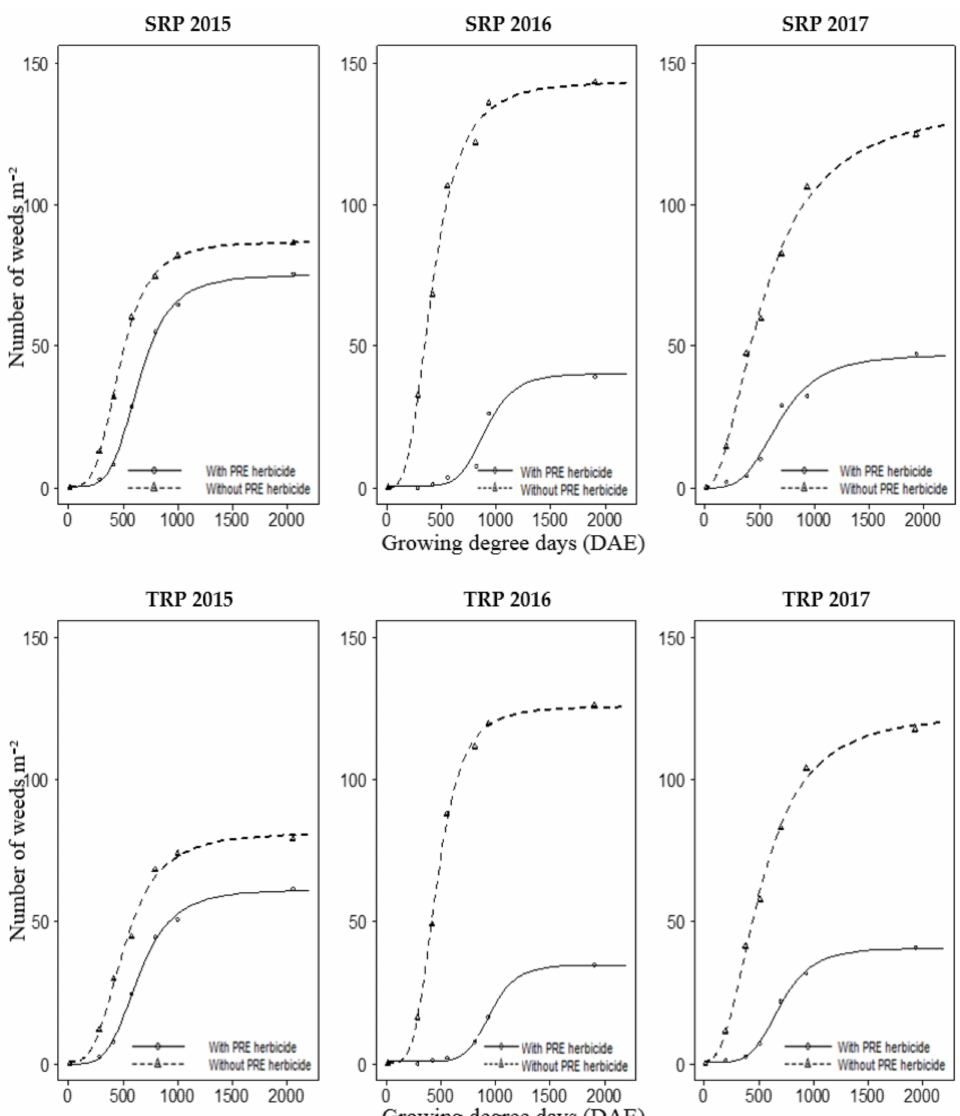
Figure 1. Total weed density response to increasing duration of weed interference as represented by growing degree days (d after emergence, DAE) grown without and with PRE herbicides in standard (SRP) and twin-row (TRP) planting patterns, at Padina, Serbia, 2015–2017. Generally, the highest weed density (143.3 weds m − 2 ) in 2016 was in both planting patterns in sub-plots without PRE herbicides with a species composition that included: S. halepense , A. retroflexus , C. album , H. annuus , Solanum nigrum , B. napus , D. stramonium, and C. arvense . Weeds surveyed during the wet season were higher than in the dry season in terms of weed composition, density, and fresh and dry weights. Additionally, the highest weed density was observed in the vegetative stage compared to the reproductive stage of the crop. However, the wet season in both planting patterns with PRE herbicides recorded the lowest total weed density with a low biomass of weeds as a consequence of the PRE herbicide reaction. In addition, the twin-row planting pattern has a positive impact on the suppression of the weed density and composition if it is compared with standard row